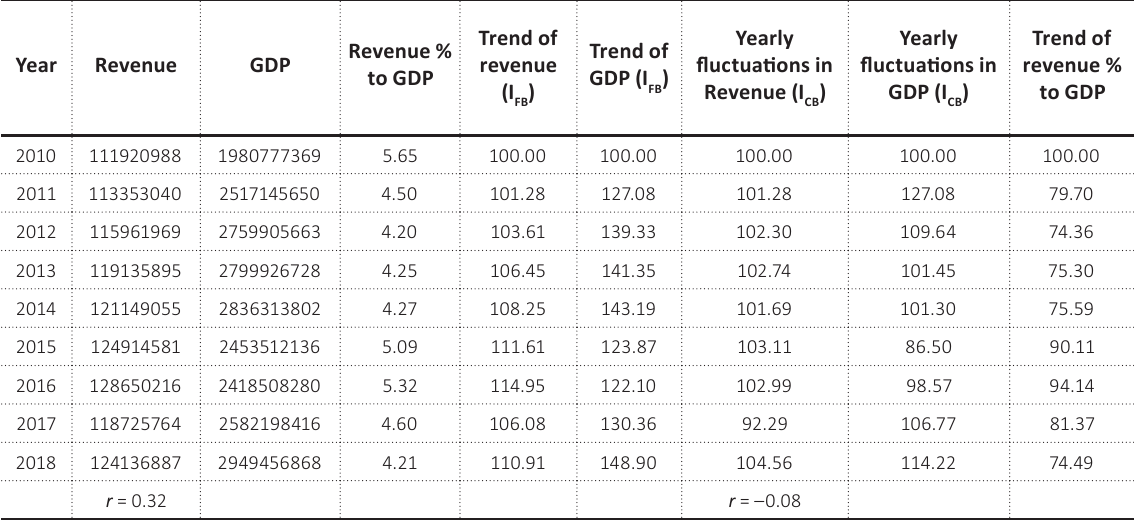
Table A1. Revenue and its contribution to the GDP and relative movement (million Riyals)